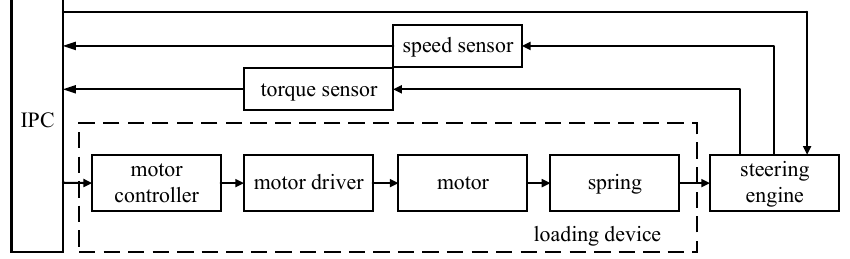
Figure 1. Single-motor electric load simulator system structure.